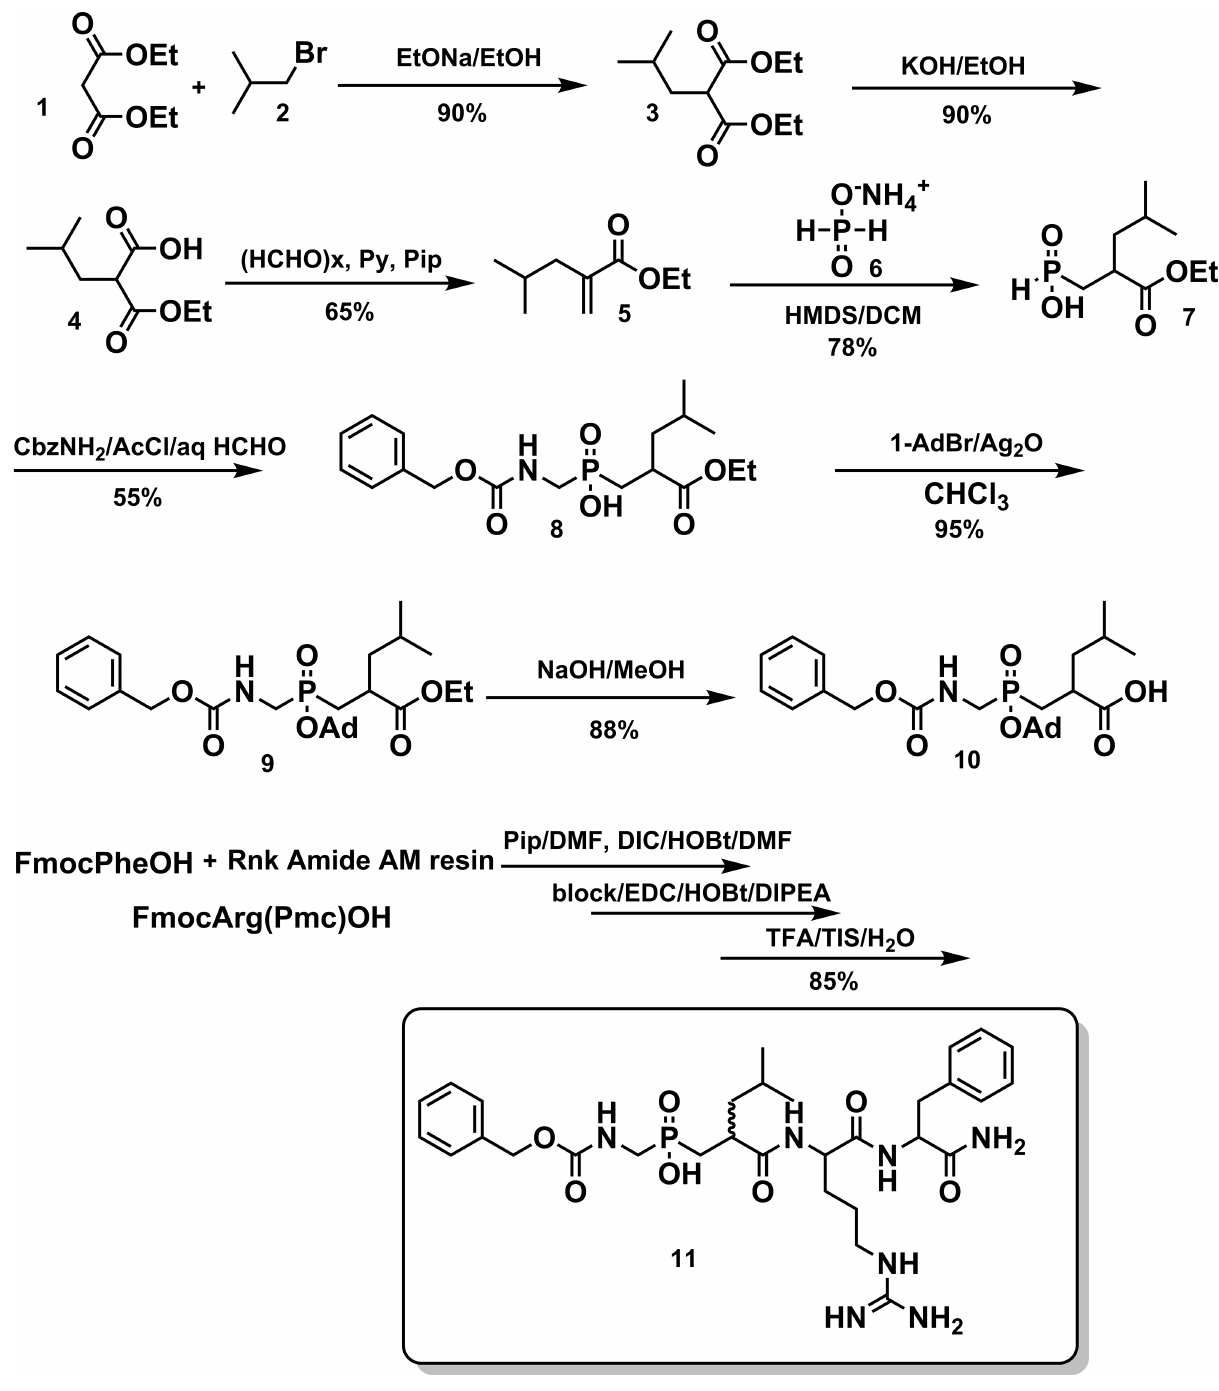
Fig 1. Synthesis of the KP phosphinic